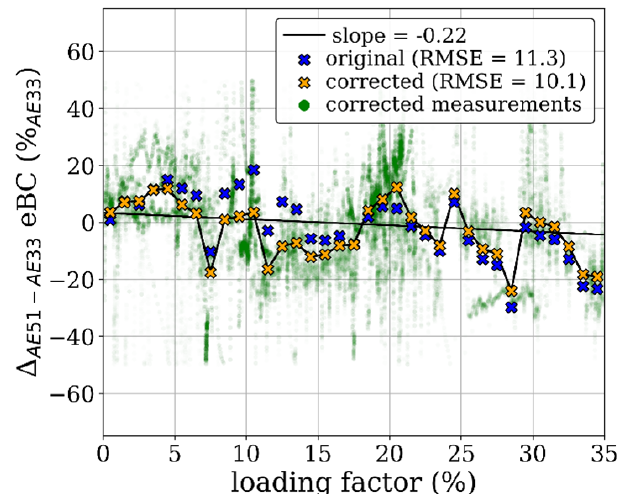
Figure 10. Dependence of the difference between the Weingartner- corrected eBC from the AE51 and the Drinovec-corrected AE33 versus the loading factor of the AE51 filter (green dots). The blue and orange crosses represent the uncorrected and Weingartner- corrected 1% averaged differences